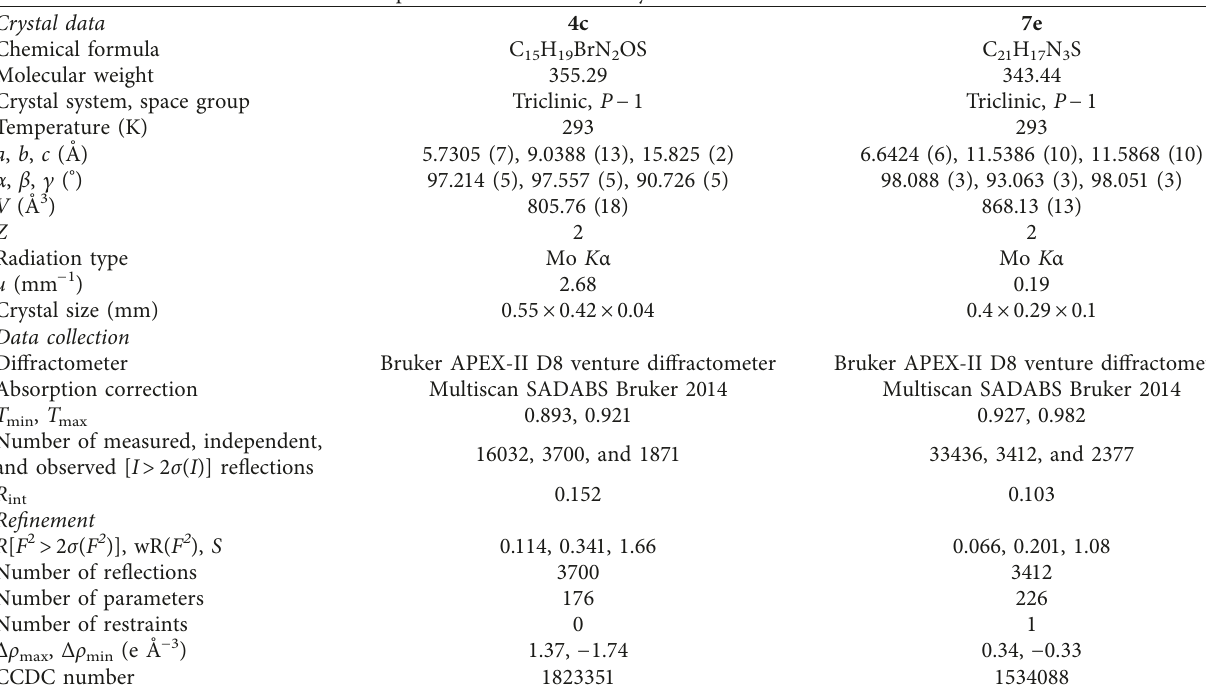
Figure 2, the asymmetric units contained one independent molecule.